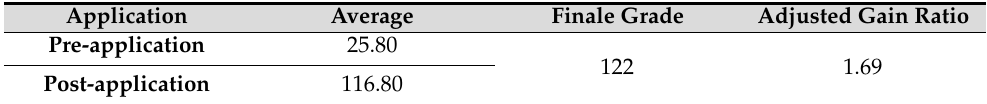
Table 10. Black’s modified gain